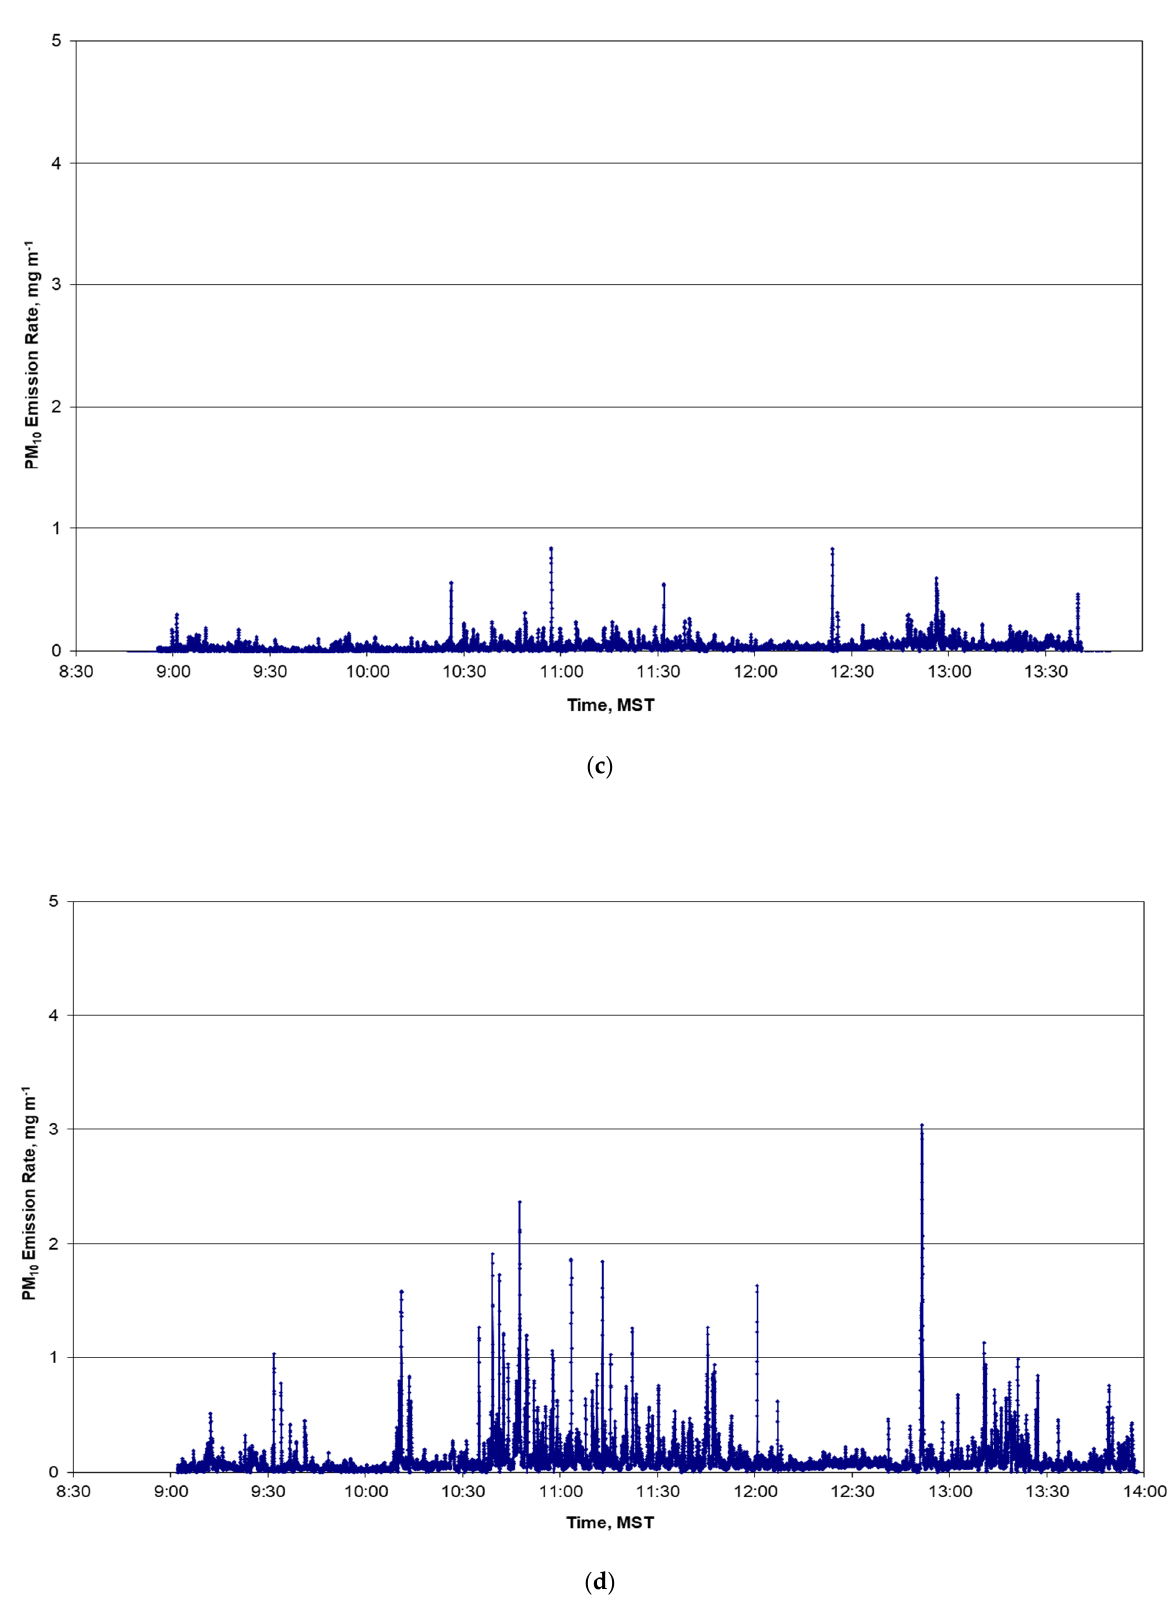
Figure 8. Time series plots of PM 10 emission rates for Friday, 22 September ( a ), Saturday, 23 September ( b ) Sunday, 24 September ( c ), and Monday, 25 September ( d